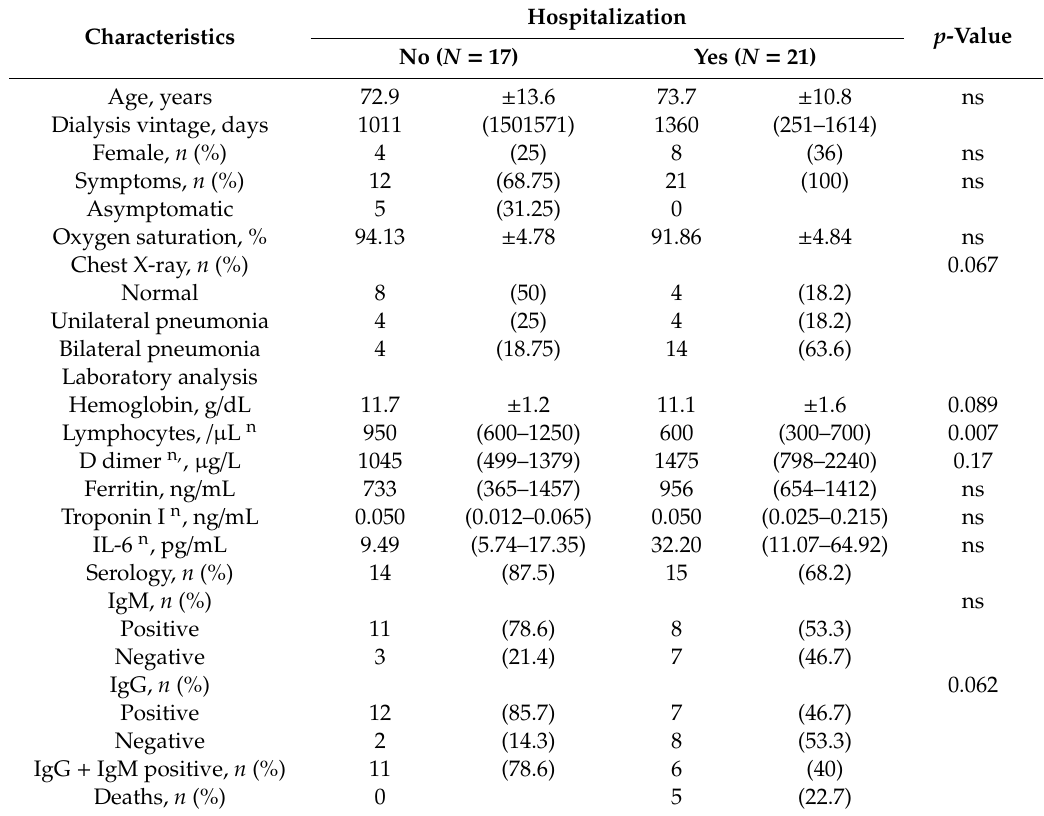
Table 2. Analysis of polymerase chain reaction (PCR) positive patients, according to hospitalization related to disease severity. Data presented as mean ± SD, median (interquartile range) or counts (percentage).